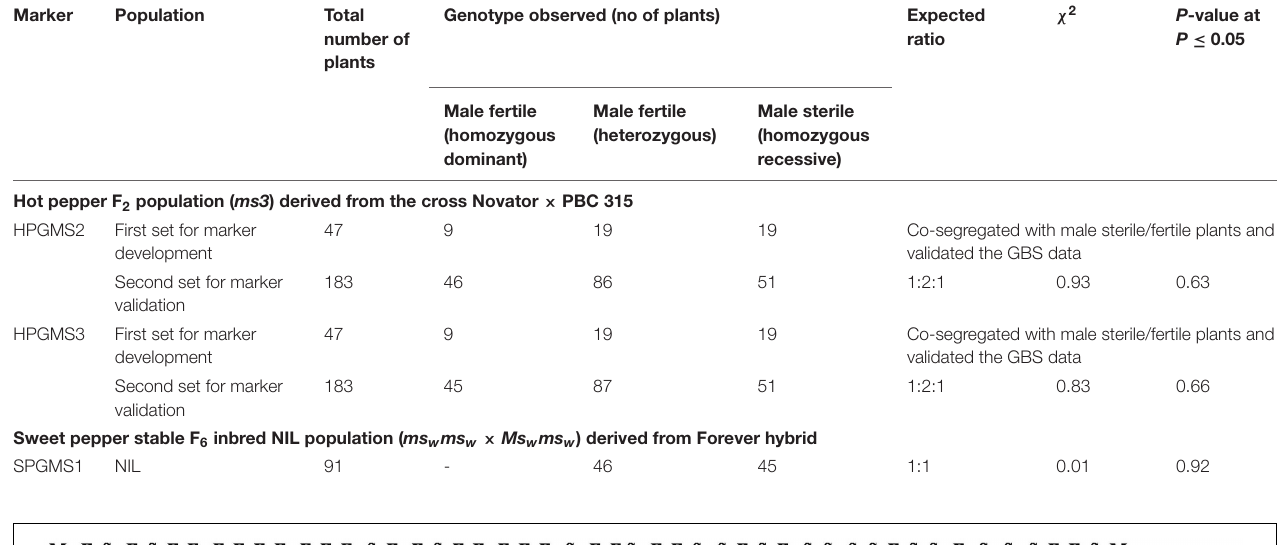
TABLE 3 | Segregation of SNP-derived markers linked to ms3 and ms w genes in hot pepper (F 2 ) and sweet pepper (near isogenic; NIL) populations. Marker Population Total Genotype observed (no of plants) number of